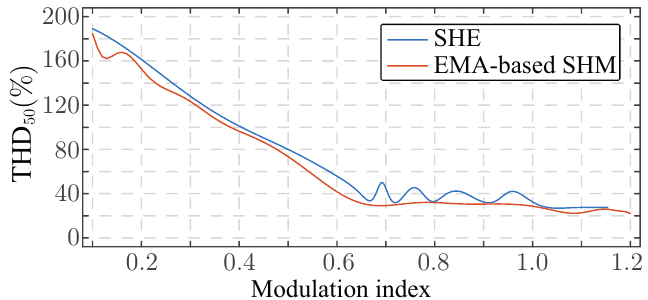
Figure 8. THD 50 (%) of the line voltage applying the SHE and EMA-based SHM methods.